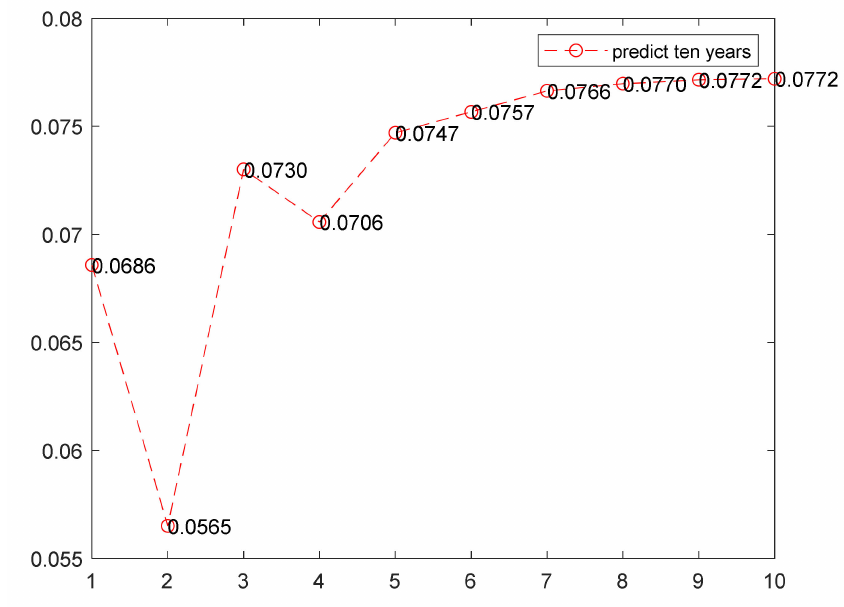
Figure 8. The prediction results of indicator N16 for the next 10